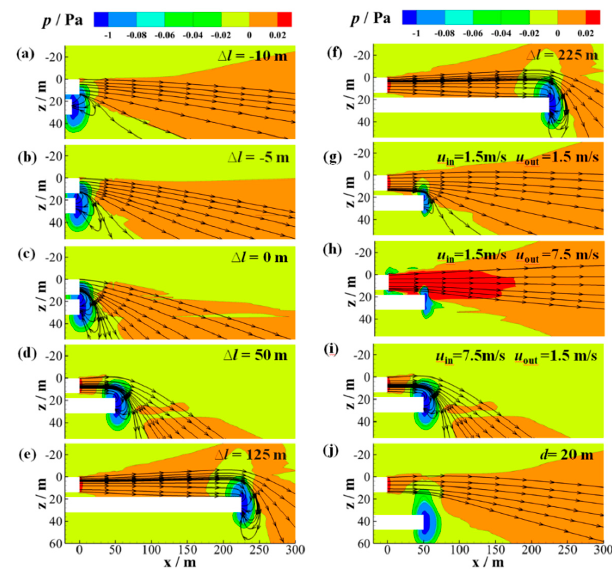
Figure 9. Flow structure at the portals of twin tunnels with small spacing.